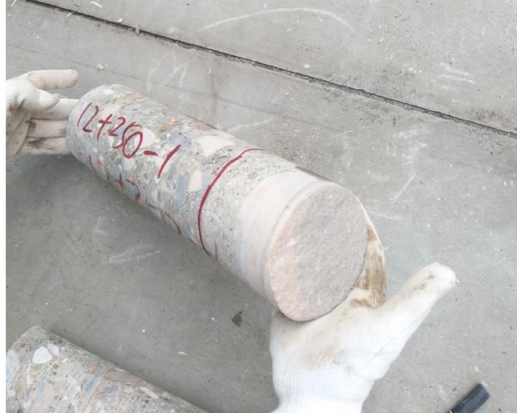
Figure 18. Core sample at the left sidewall test station at section 12+250.